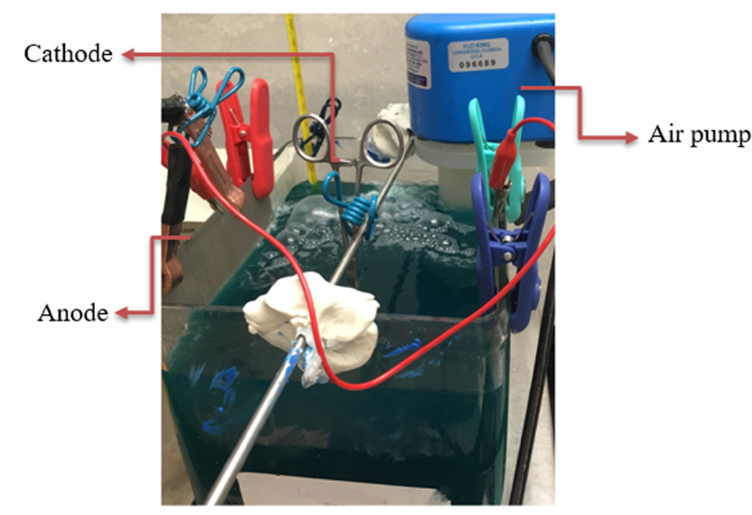
Figure 2. Image of the electrodeposition bath setup.